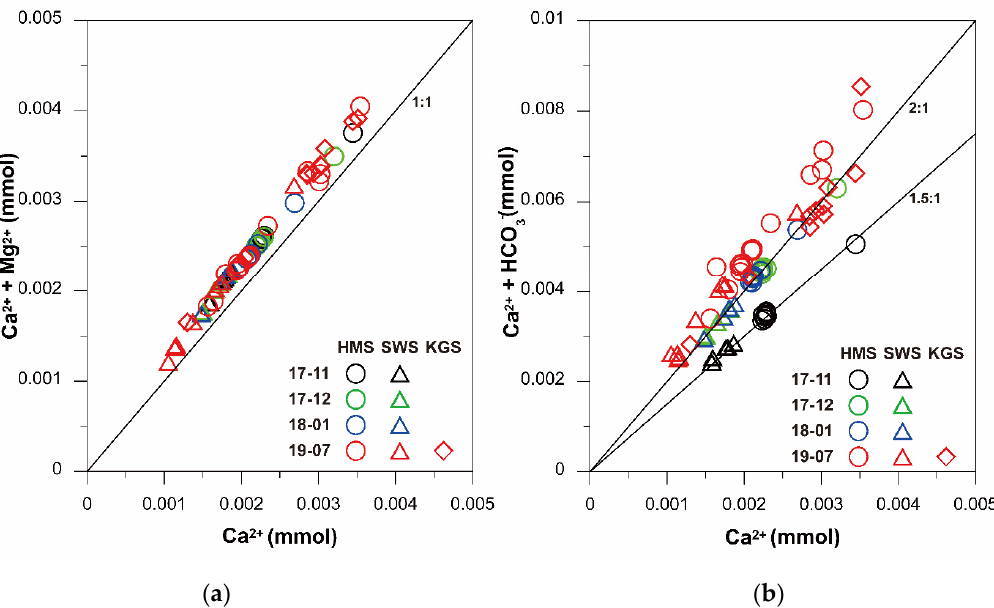
Figure 5. Relationships between Ca 2+ , Ca 2+ +Mg 2+ , and Ca 2+ +HCO 3 − for the surface water in Samcheok: ( a ) relationship between Ca 2+ and Mg 2+ ; ( b ) relationship between Ca 2+ and HCO 3 − .